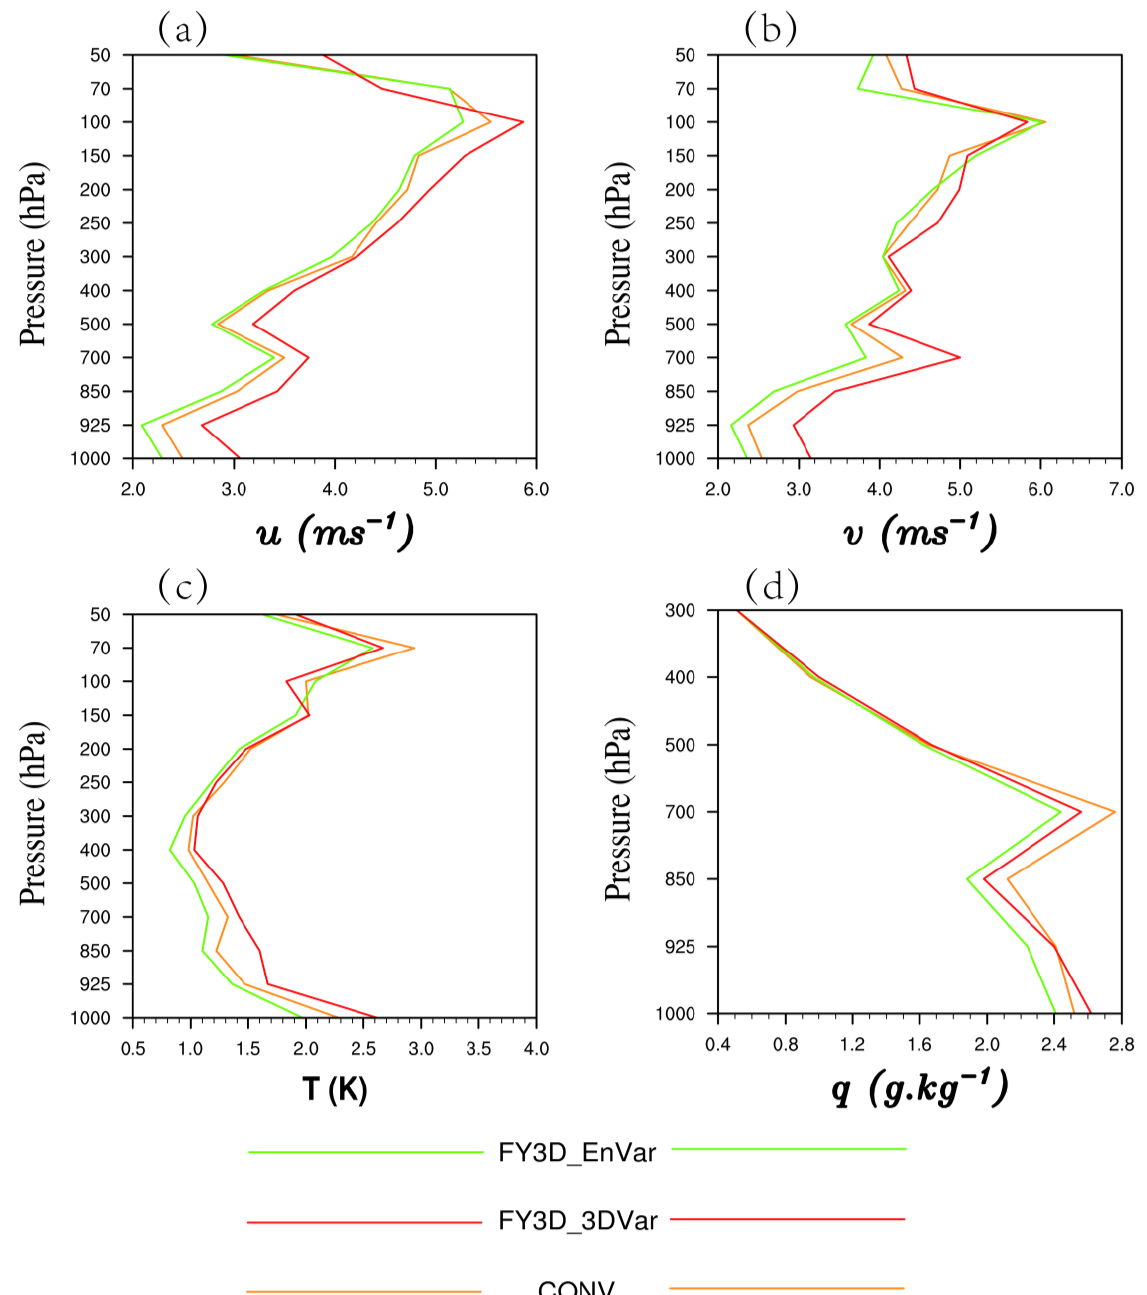
Figure 12. RMSE of the ( a ) zonal wind speed (unit: m/s), ( b ) meridional wind speed (unit: m/s), ( c ) temperature (unit: K), and ( d ) specific humidity (unit: g/kg) averaged from 24-h forecasts initialized from each analysis.